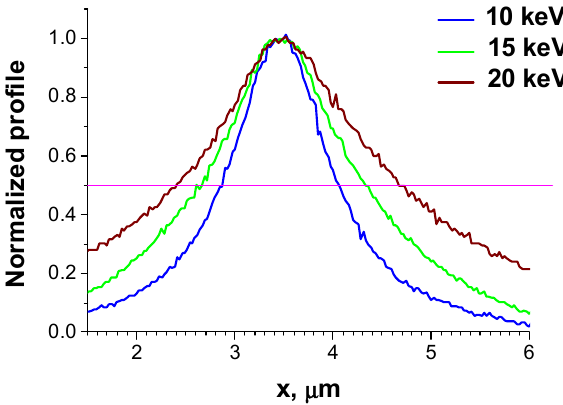
Figure 7. Profiles of the EBIC image of the same bright spot measured at a few E b values. A solid line marks the half maximum position.